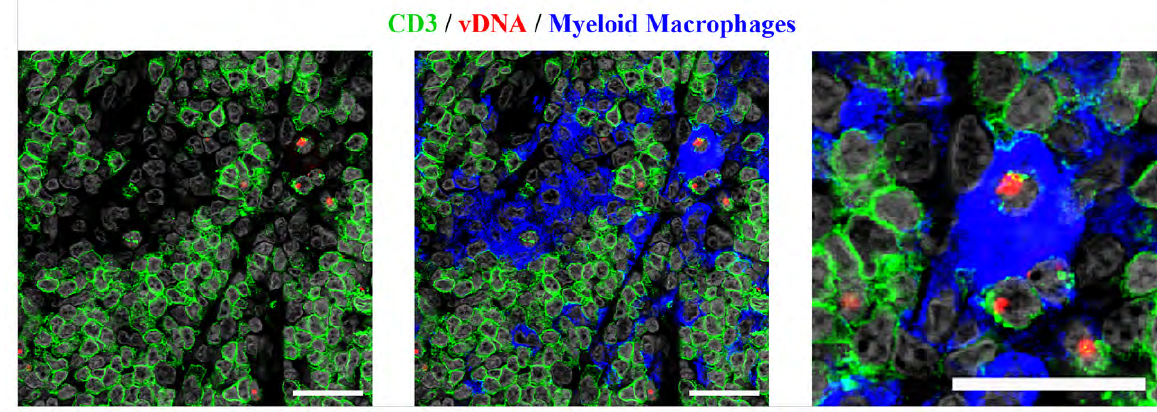
Supplemental Figure 6. Macrophage phagocytosis of vDNA+ T cells in secondary lymphoid tissues in vivo . Confocal analysis of an acutely SIV-infected lymph node showing vDNA detection (red) with cell phenotypic immunofluorescence analysis of CD3+ T cells (green) and CD68+/CD163+ myeloid lineage cells (blue), demonstrating (arrows) the detection of macrophages that have ingested vDNA+ T cells (ar- rows). Scale bars = 25